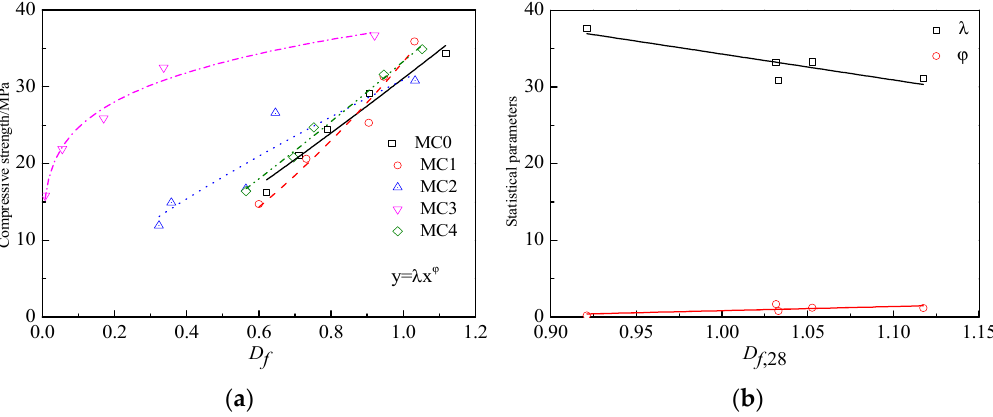
Figure 7. The relationship between compression strength of NCM and statistical parameters and D f : ( a ) R c with D f ; ( b ) statistical parameters with D f ,28 .